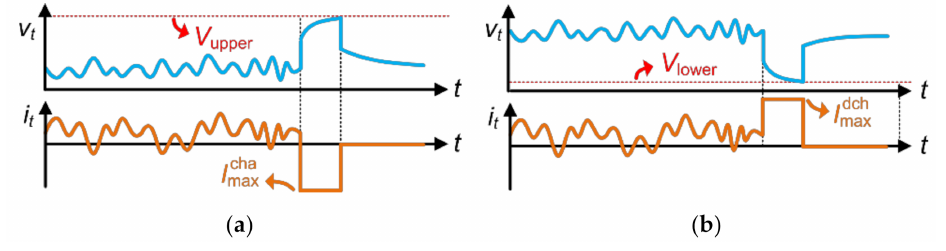
Figure 1. Conceptual depiction of the maximum peak current: ( a ) I cha max ; ( b ) I dch max . The maximum peak current is estimated based on an equivalent circuit model (ECM) consisting of an OCV and a diffusion resistance ( R s ) based on the voltage drop for 1 s, as shown in Figure 2 [25]. In plenty of literature, n-th order resistor − capacitor (RC)